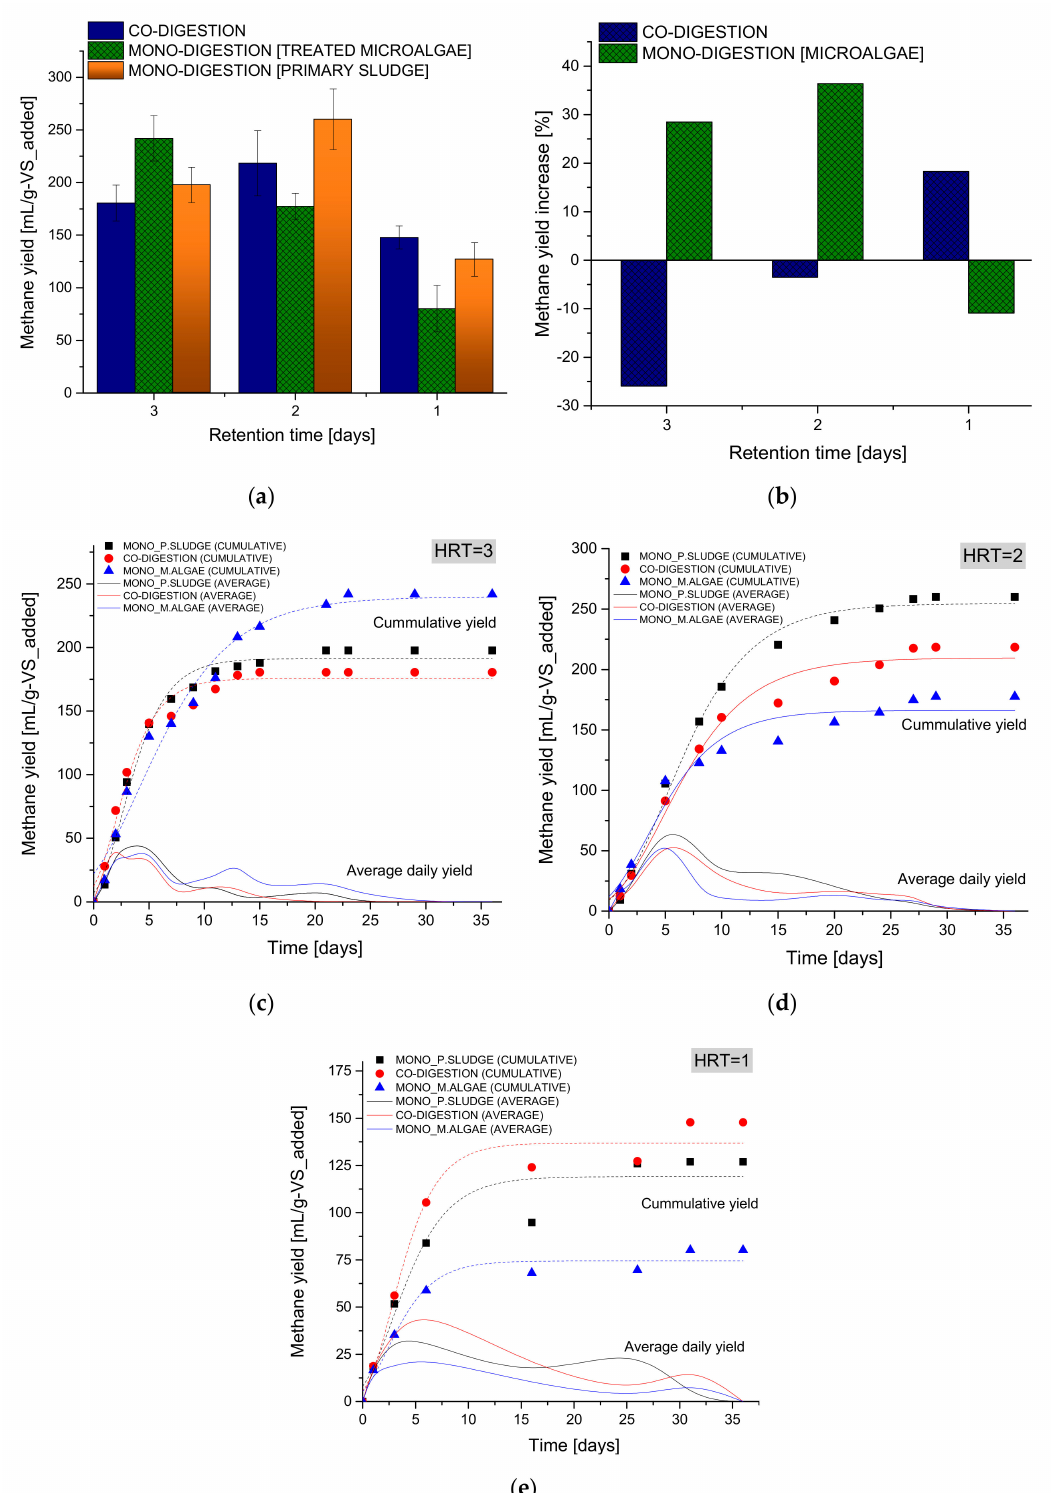
Figure 5. Methane yield at di ff erent HRTs after 85 ◦ C anaerobic biological pretreatment: ( a ) experimental maximum yield; ( b ) percentage increase in methane yield as compared to no pretreatment condition; ( c – e ) experimental vs. simulated values at di ff erent HRTs [Experimental condition: Mesophilic AD temperature = 35 ◦ C, Sludge / algae ratio for co-digestion = 9, pH = 7.1 ± 0.2, ISR = 2, Working AD volume = 150